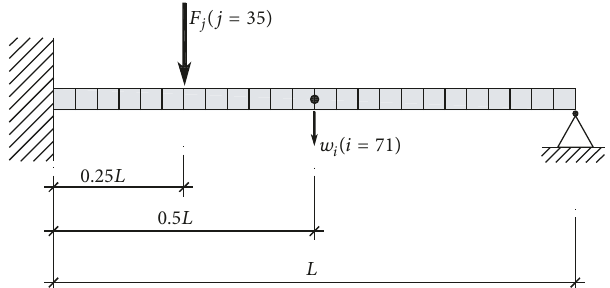
Figure 4: Example 2: viscoelastic 1D structures. Location of the excitation force and the response for the computation of the frequency response function